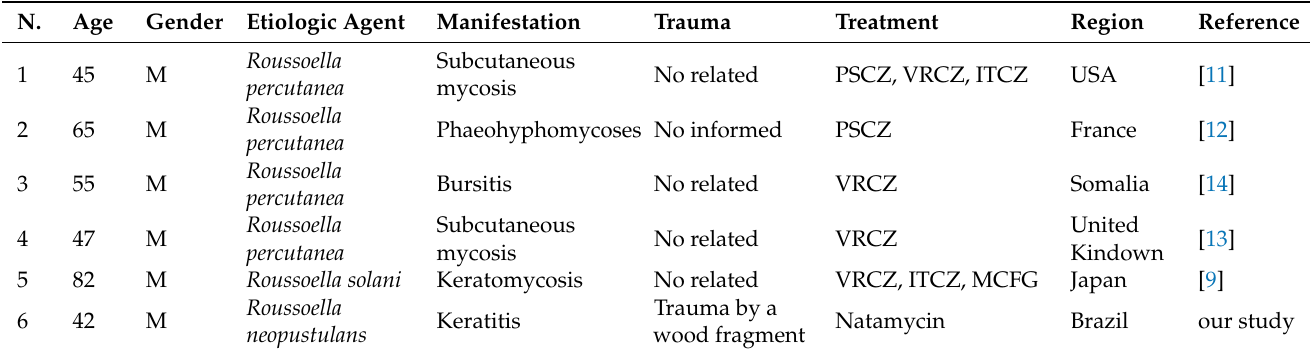
Table 1. Clinical cases overview of Roussoella